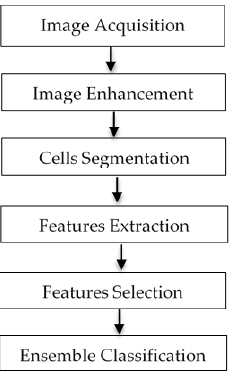
Figure 2. The methodology of proposed cervical cancer detection and classification system.